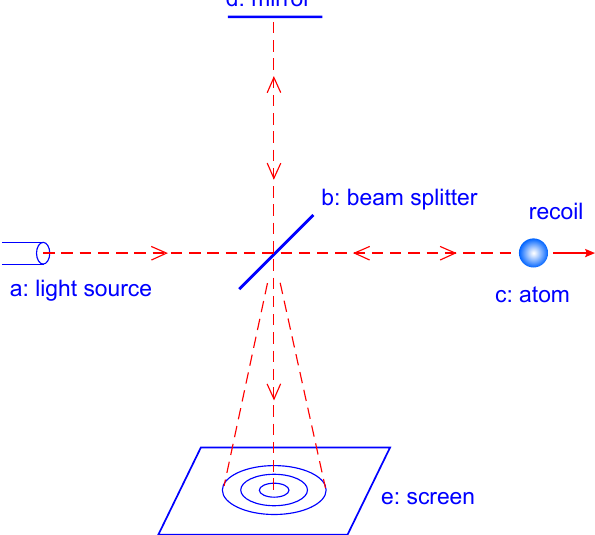
Figure 2: The Michelson interferometer with a recoiling